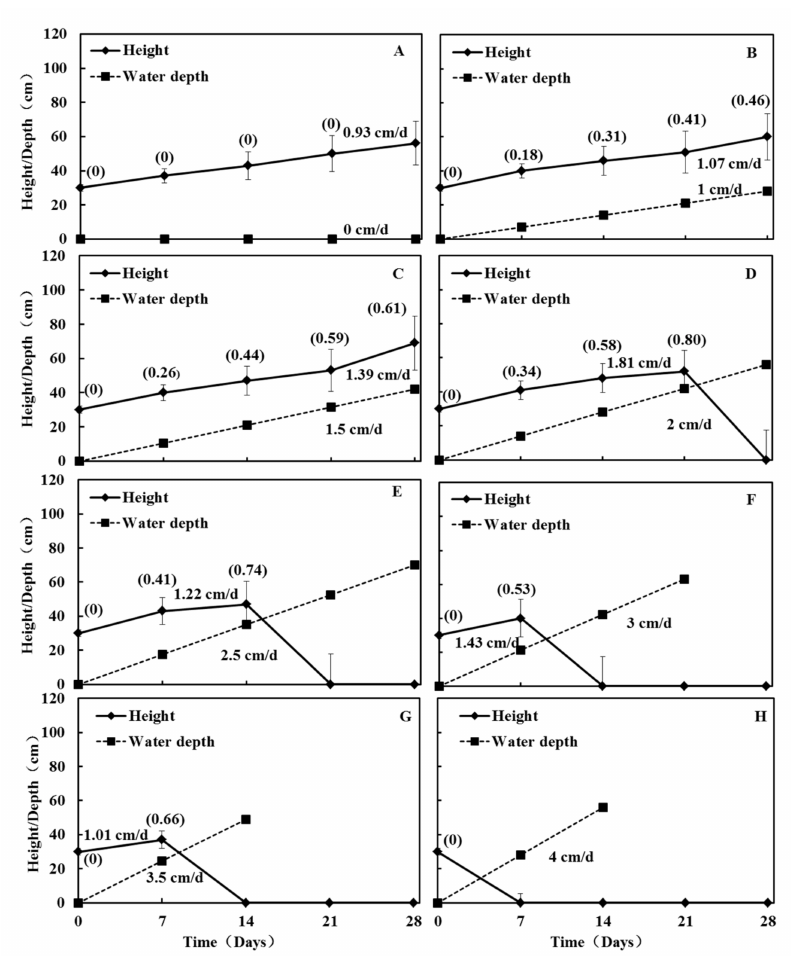
Figure 7. Responses of seedlings of Typha angustifolia to submergence rate (( A – H ) 0–4 cm / d) over 28 days in a pond experiment. Submergence rates: ( A ) 0 cm / d; ( B ) 1 cm / d; ( C ) 1.5 cm / d; ( D ) 2 cm / d; ( E ) 2.5 cm / d; ( F ) 3 cm / d; ( G ) 3.5 cm / d; ( H ) 4 cm / d. Bars indicate ± standard error. Height represents the length from the base of the plant to the tip of the topmost unfolded leaf. The dotted line shows the cumulative water level. Ratios of the submerged plants have been shown in parentheses above datum